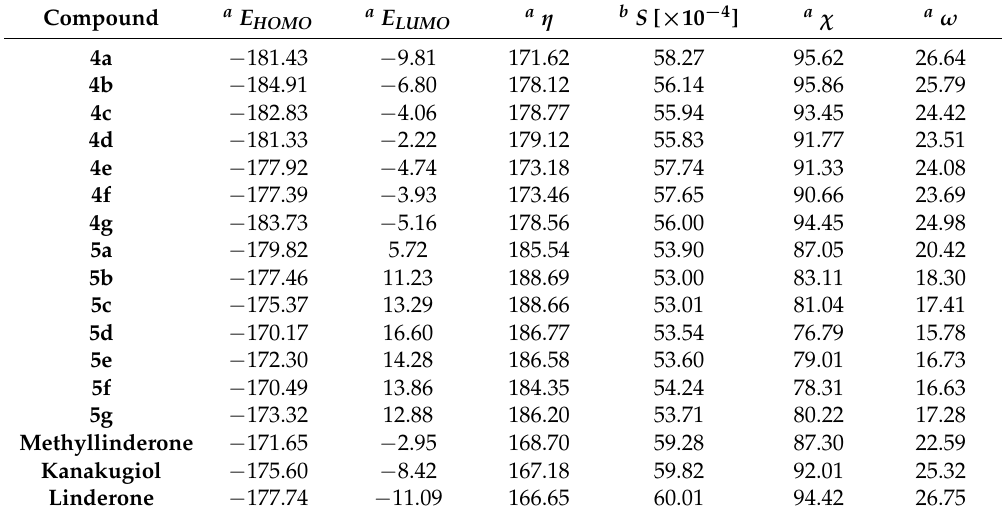
Table 4. Global reactivity indexes for compounds 4a – g , 5a – g and inhibitors of chitin synthase 2 from S. erevisiae